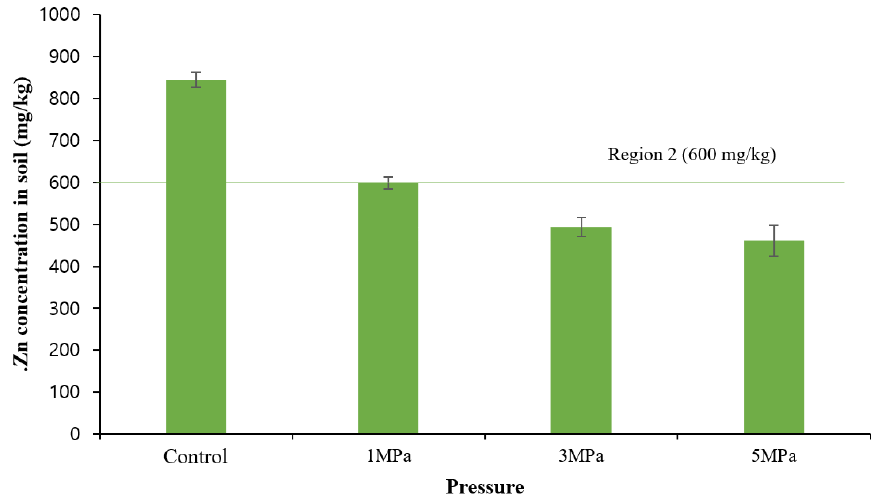
Figure 4. Pb concentrations remaining in the soil after high-pressure washing at 1, 3 and 5 MPa.